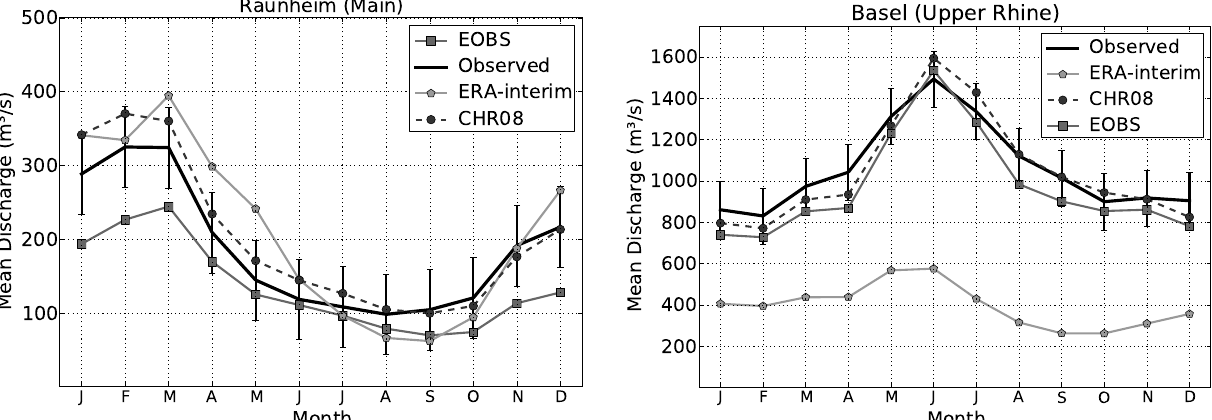
Fig. 5. Mean annual cycle of observed and modeled discharges at Raunheim (left panel) and Basel (right panel) for the period 1990–2008. Also shown are the 95% confidence intervals from the interannual variability of the observed